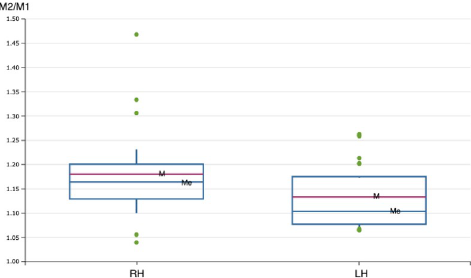
Fig 2. Box graphic for M2/M1 ratios plotted with mean [M], median [Me], and standard deviation [the latter delimited by upper and lower lines of the box], and outlier points shown in green color. RH is right hemisphere; LH is left